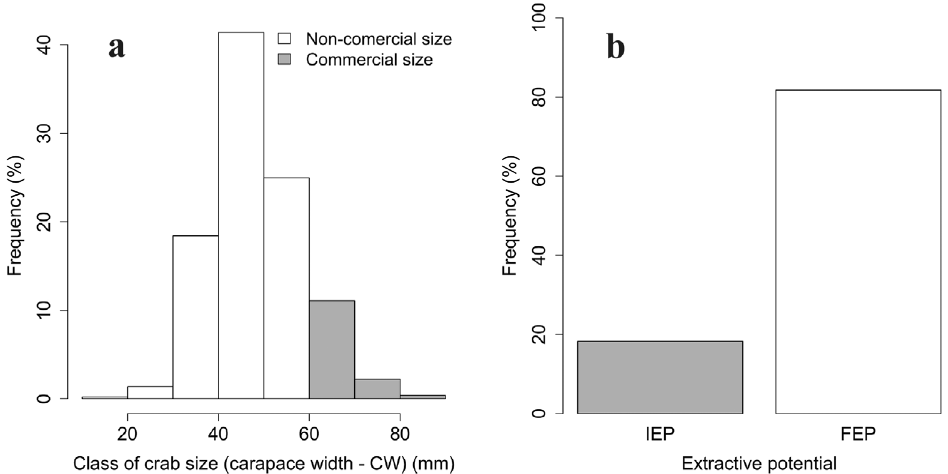
Figure 5 - Population and fishery parameters of U. cordatus in the mangroves of Iguape. ( a ) Size- frequency distribution by carapace width classes. ( b ) Immediate Extractive Potential (IEP) and Future Extractive Potential (FEP)